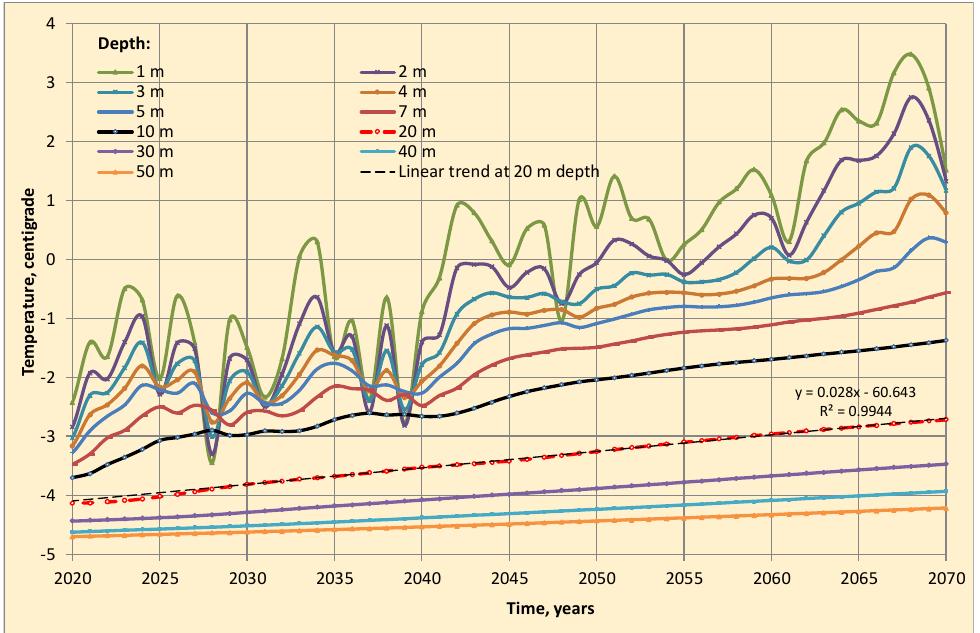
Figure 1. Forecast of the mean annual permafrost temperature vs. time (years) for different depths for Point “631—Marre-Sale” (Western Yamal), scenario RCP-8.5, undisturbed conditions. The areas of use of the results of the geocryological forecast are, at the same time, the areas of implementation of adaptation approaches and technologies: